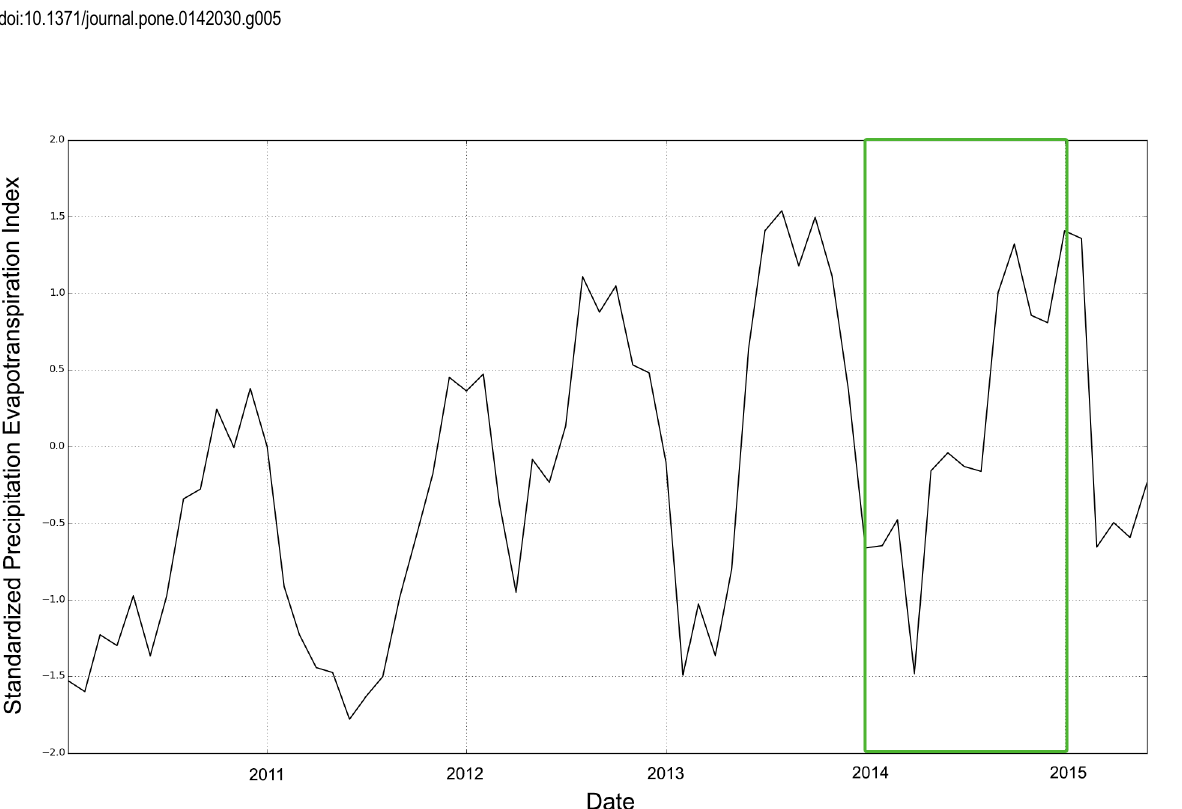
Fig 6. Standardized Precipitation Evapotranspiration Index (SPEI) for the location of Kabo (18.61E/7.69N), covering January 2010 to May 2015 based on a time-scale of 6 months.